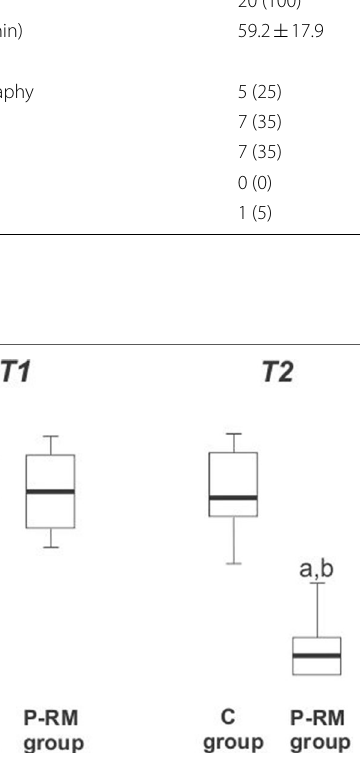
Fig. 3 The aeration score during the study. Box-plot showing the aeration score after anesthesia induction (T1) and after 3 min of 10 cmH 2 O of PEEP in the control (C group) and postural recruitment maneuver (P-RM group) groups. Inter-group comparison, Student’s t test: a C group vs P-RM group at T2, p < 0.0001. b P-RM group T1 vs T2, p <